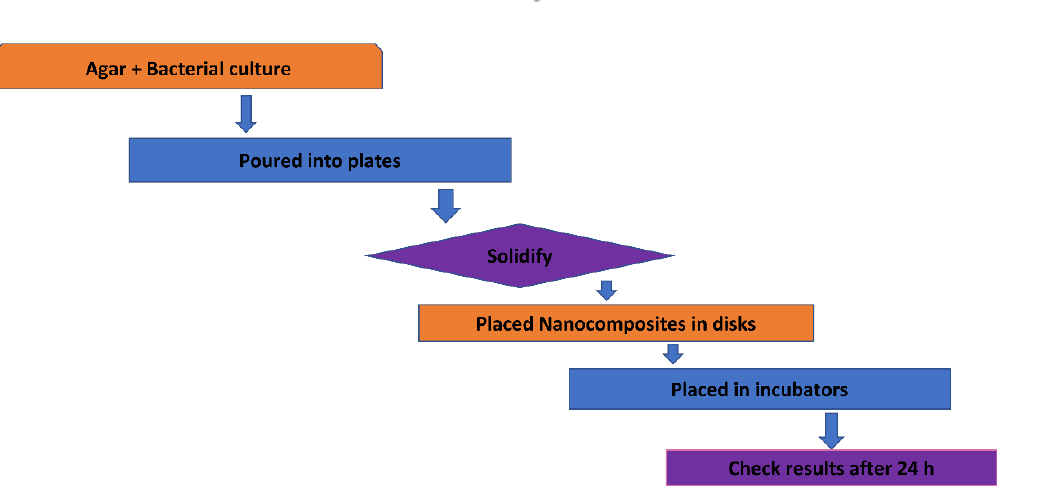
Figure 8. Schematic representation of the antibacterial activity of green-synthesized Ag NPs.